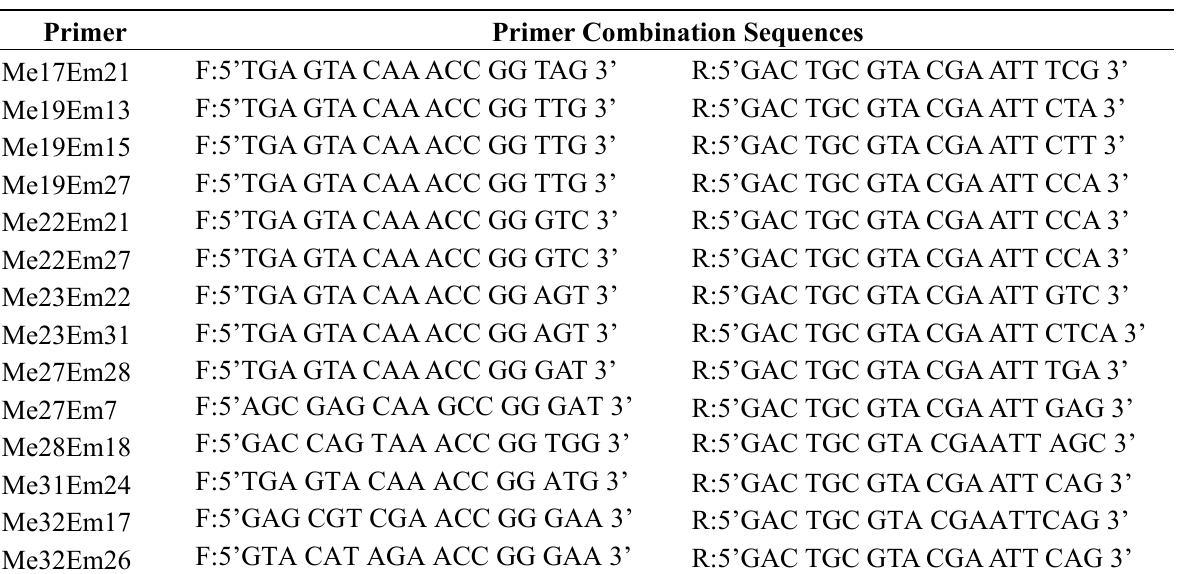
Table 2. Primer sequences used in SRAP analysis of T.